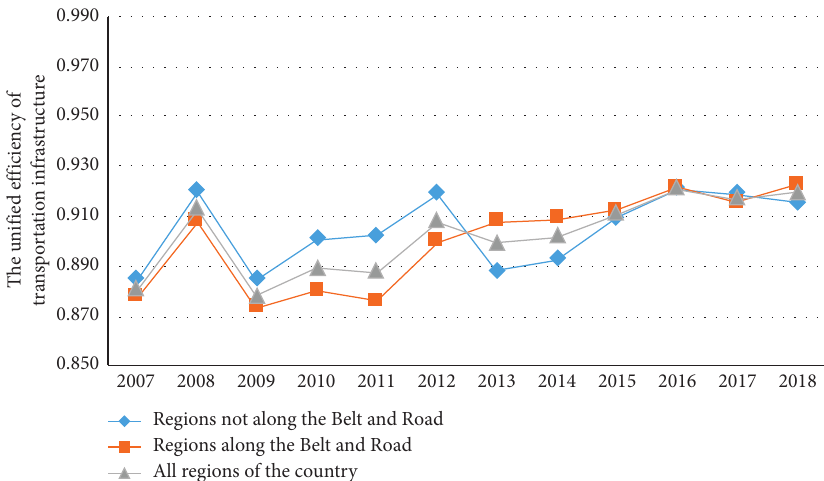
Figure 4: Trending in unified economic and environmental efficiency of transportation